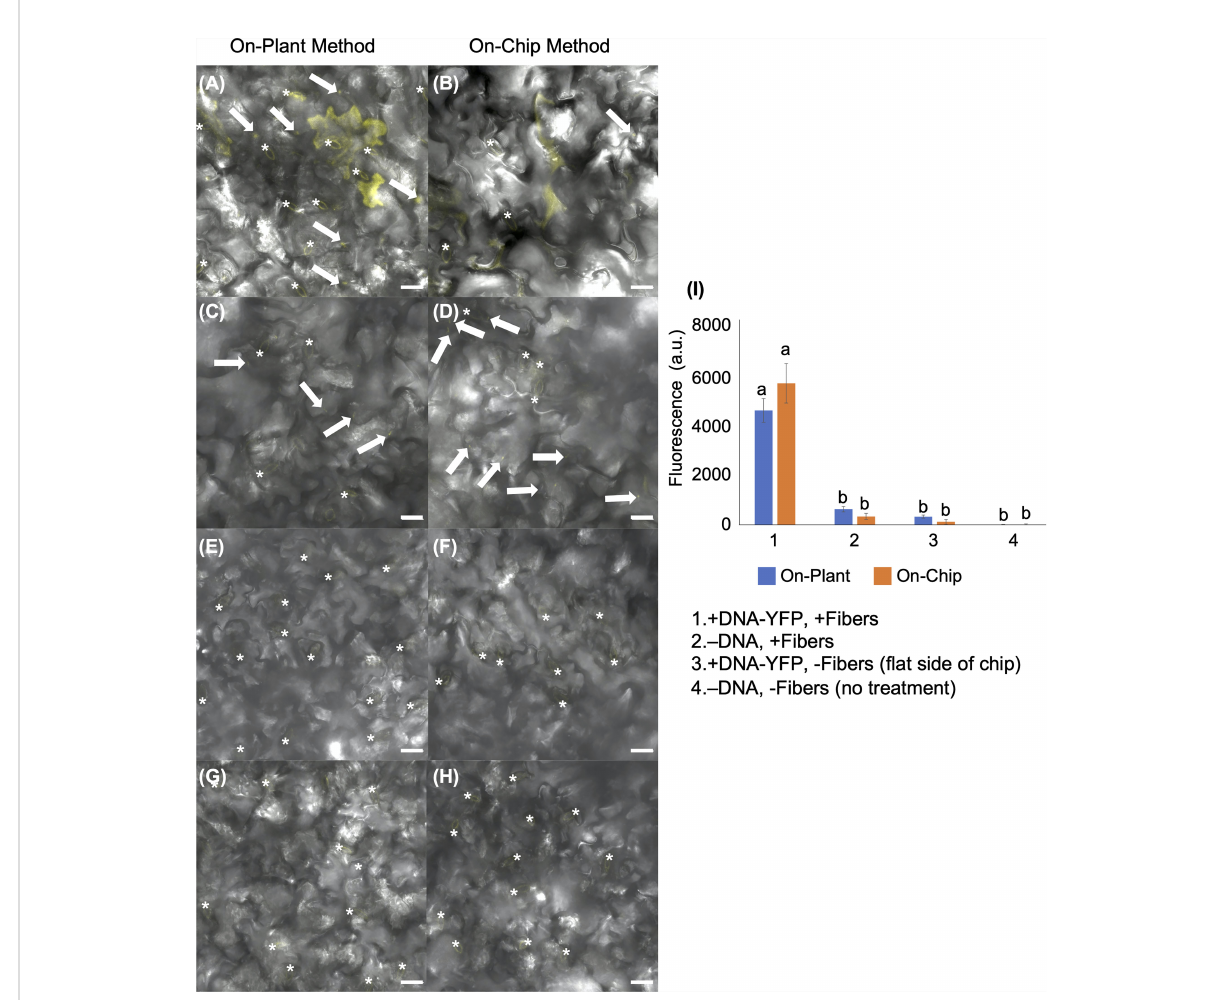
FIGURE 3 Fluorescent image analysis of Arabidopsis leaves transiently transformed with pUBQ 10 :YFP 48 h after delivery via VACNF with a 35 µm pitch using the on-plant or on-chip methods. (A) and (B) DNA-YFP delivery via VACNF using the on-plant and on-chip methods, respectively (+DNA- YFP, + fi bers). (C) and (D) Fibers only ( – DNA, + fi bers). (E) and (F) DNA-YFP delivery without fi bers ( fl at chip: +DNA-YFP, − fi bers). (G) and (H) No treatment ( − DNA, − fi bers). (I) Graph representing relative average fl uorescence signal intensity of 25 20×20 m m areas from images of 5 biological replicates combined from 2 – 3 experiments using fl uorescence from the YFP channel. Regions containing stomata (*) were excluded due to auto fl uorescence, and the average fl uorescence intensity from the no-treatment condition was subtracted from each average. 2-way ANOVA (and Tukey test) was used for signi fi cance testing, and error bars represent the standard error of the mean. Different letters show signi fi cant differences between treatments ( P < 0.0001). All images shown are maximum projections of 40 m m z-stacks. Scale bars are 20 m m, and white arrows indicate fi bers in the